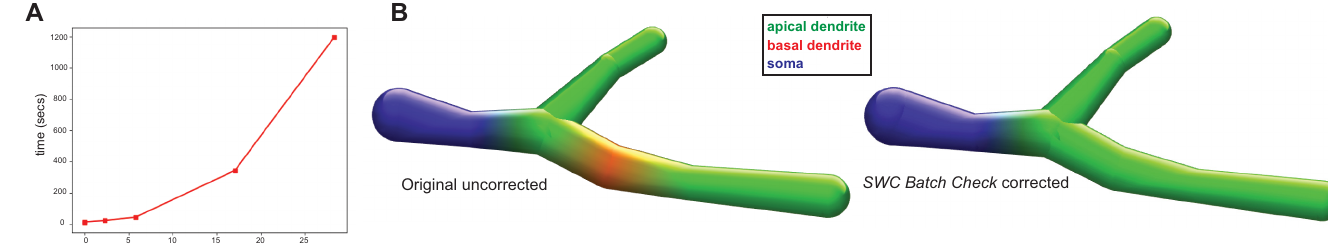
Fig 1. Runtime performance testing of SWC_BATCH_CHECK . (A) Directories containing different numbers of SWC formatted files were provided as input and ran using default settings. Directory sizes were: 0.000285MB, 0.000627MB, 2.320682MB, 5.773404MB, 17.037202MB, and 28.301MB. From this analysis the equation of the regression line was y = 2.631 + 0.023 � x; correlation coefficient, r = 0.9469. (B) Validation testing of uncorrected SWC file containing an incorrectly connected basal and apical dendrite (left image) and a SWC file corrected using SWC_BATCH_CHECK (right image) that fixes the inconsistency of apical to basal connection. Images were rendered using SharkViewer